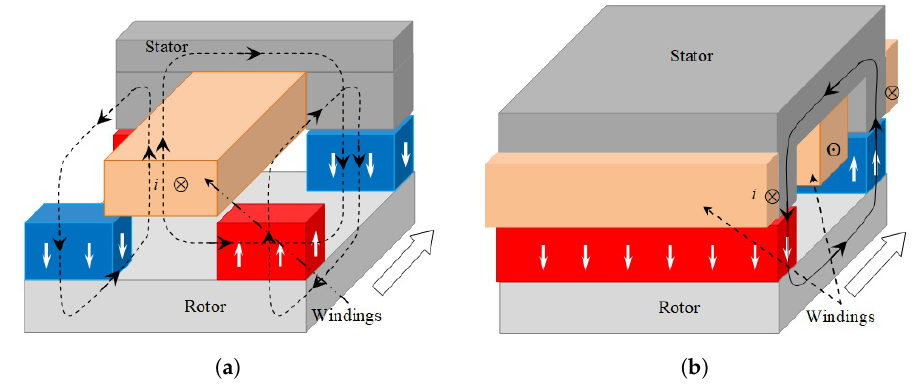
Figure 11. Flux path in one pole pair of longitudinal and transverse. PMSG ( a ) Longitudinal. ( b )